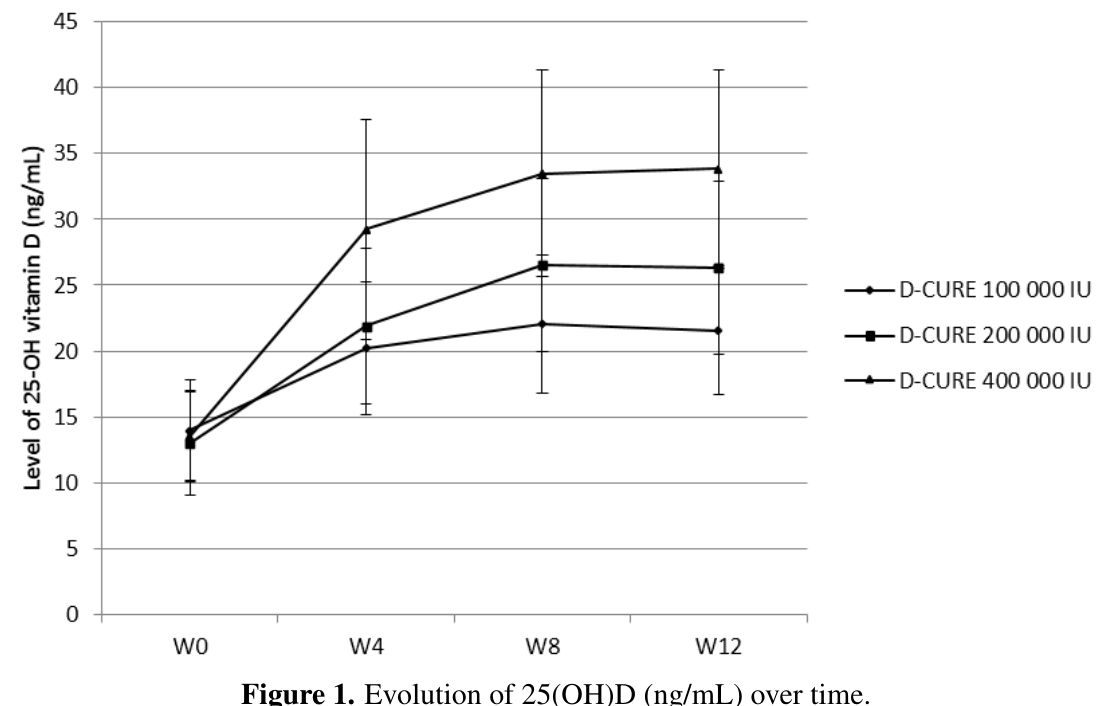
Figure 1. Evolution of 25(OH)D (ng/mL) over time.